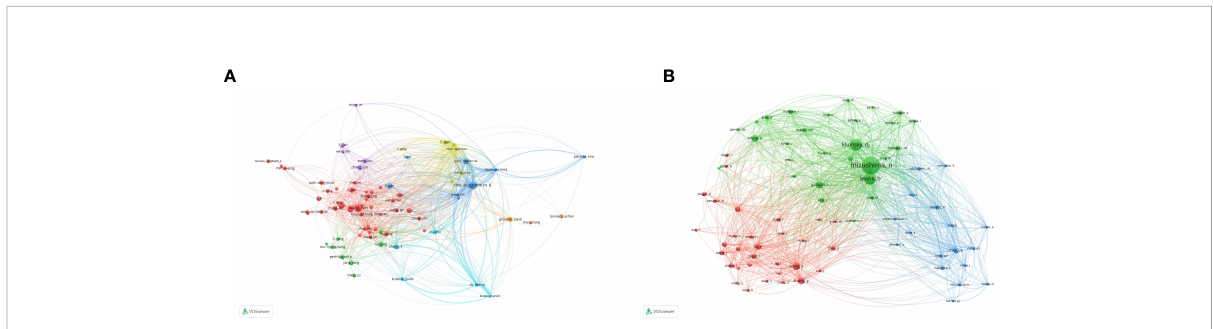
FIGURE 4 Authors related to the research on autophagy in lung disease. (A) Author co-occurrence. (B) VOSviewer visualization of co-cited authors. Circle size means the number of authors ’ published articles; the connecting lines stand for authors ’ mutual communication and